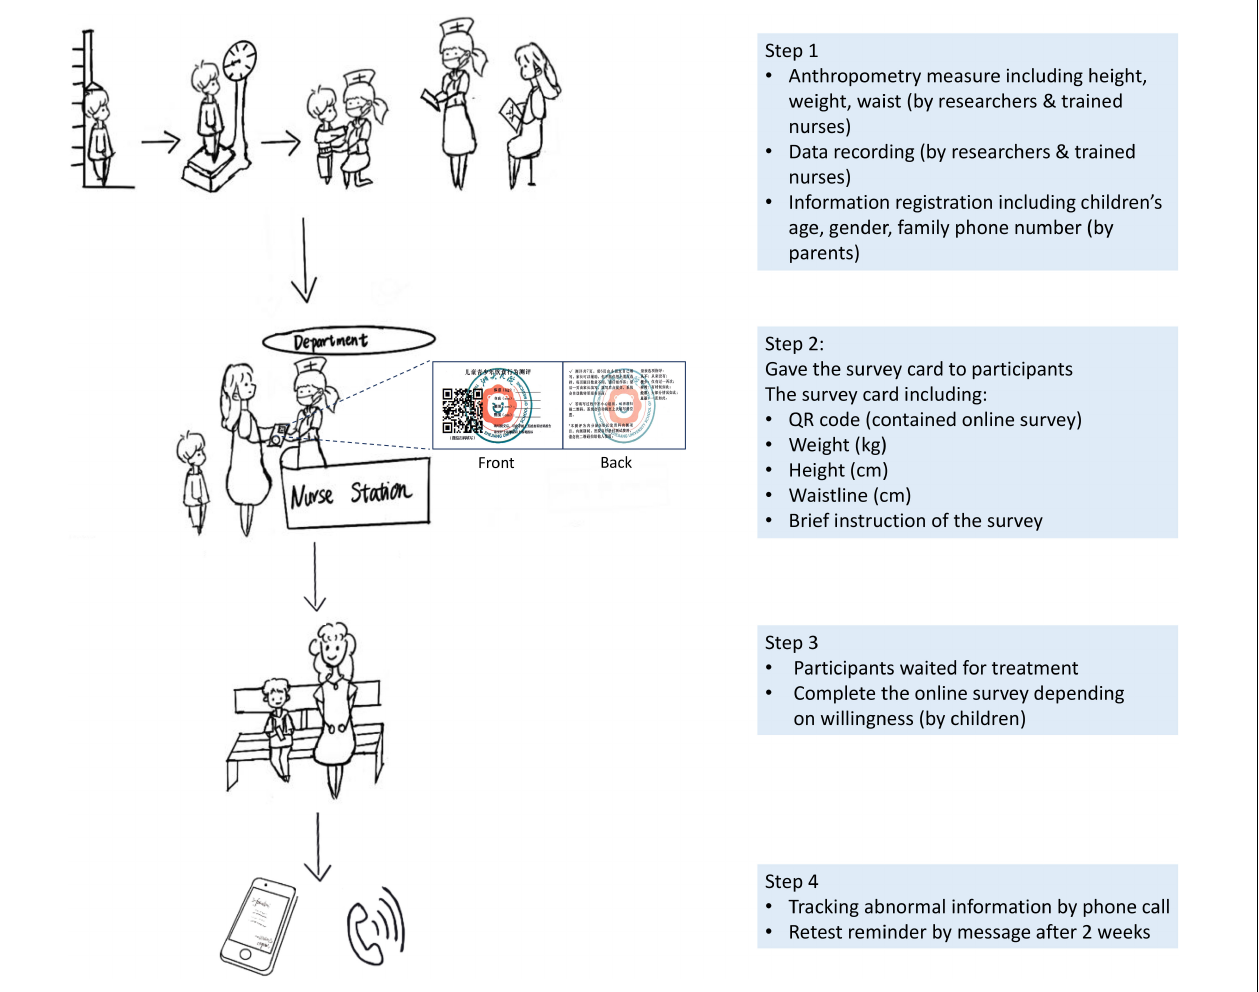
FIGURE 1 | Data collection